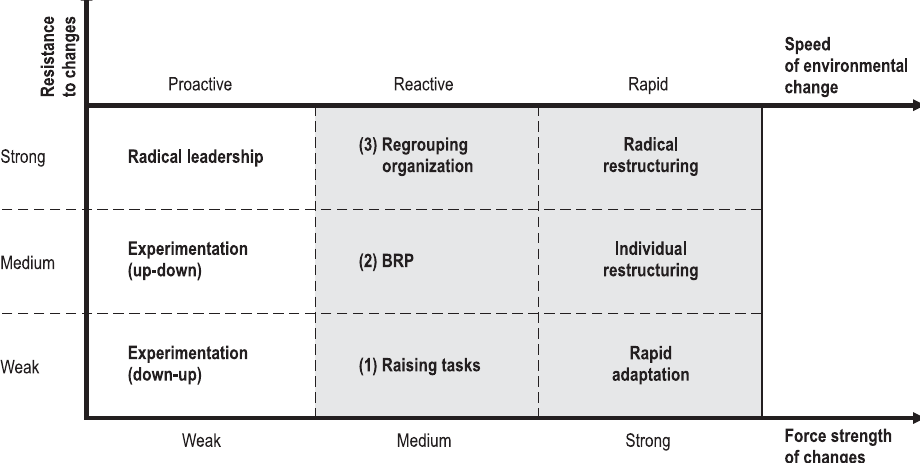
Fig. 1. Model of change management